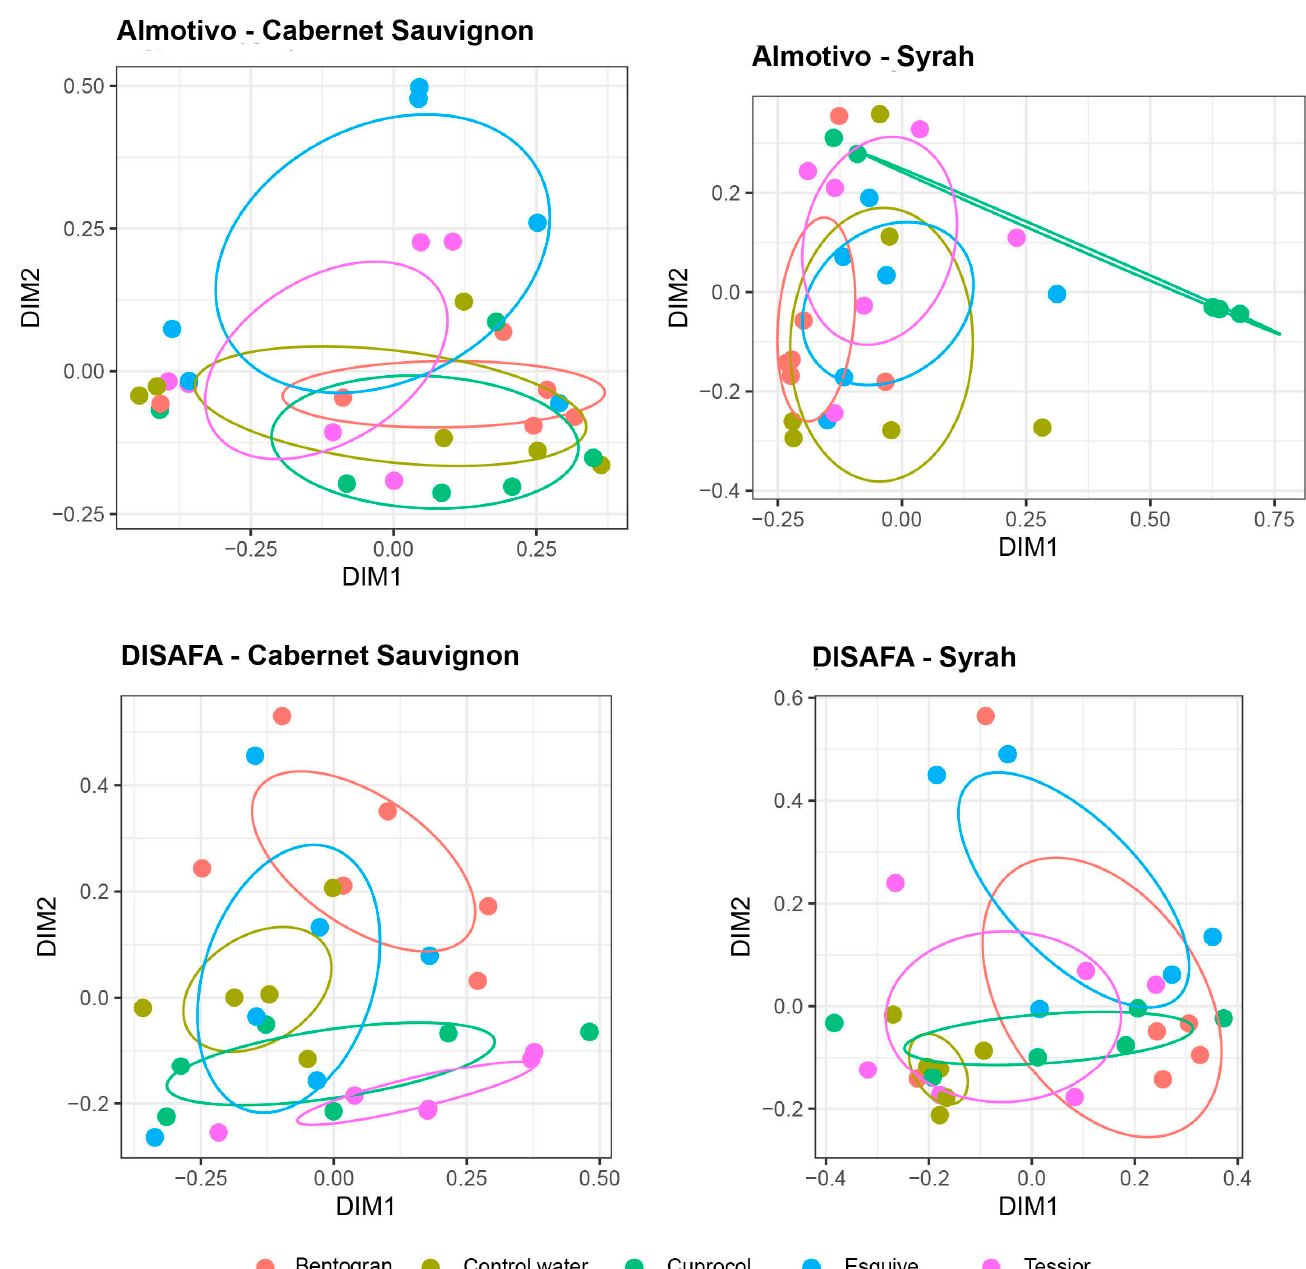
Figure 5. PCoA plots of beta dispersion based on the Bray–Curtis dissimilarity of the fungal communities in canes treated with different pruning wound protection products (Bentogran, Control water, Cuprocol, Esquive and Tessior) in Cabernet Sauvignon and Syrah from the Almotivo and DISAFA vineyards. Ellipses illustrate the multivariate normal distribution of samples within the same pruning wound protection product treatment.